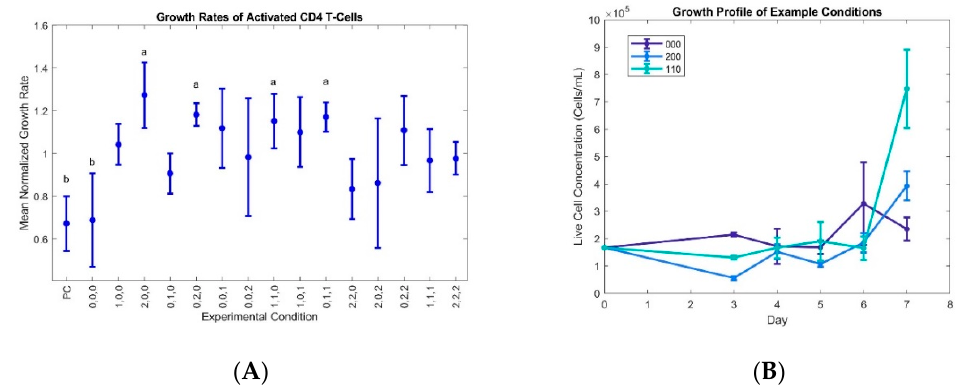
Figure 1. Various combinations of the IL-2, IL-7, and IL-15 cytokines differentially regulate activated CD4 + lymphocyte proliferation: ( A ) Mean growth rate data were obtained in four data sets, with growth rates calculated for a four-day period after post-thaw acclimation, and each set normalized to its respective average growth rate. Error bars represent ± 1 SE, and grouping letters show statistically significant di ff erences ( α < 0.05) as measured by pairwise t -tests. p -values are shown in Table 1. Note: “a” in the figure indicates conditions with growth rates significantly higher than the negative control and the baseline 000 conditions; and “b” represents the negative control and 000 conditions (see Table 5 for experimental concentrations). ( B ) Example growth profile of selected conditions, where cytokines were added on day 3 and growths rates calculated between days 3 and 7. Error bars represent ± 1 SD. Full data sets are available upon request.